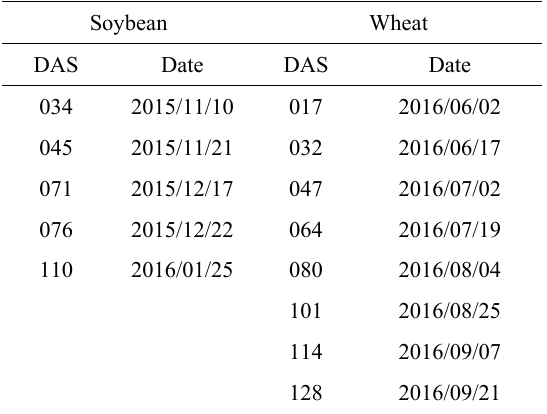
Table 1. Dates of height and LAI